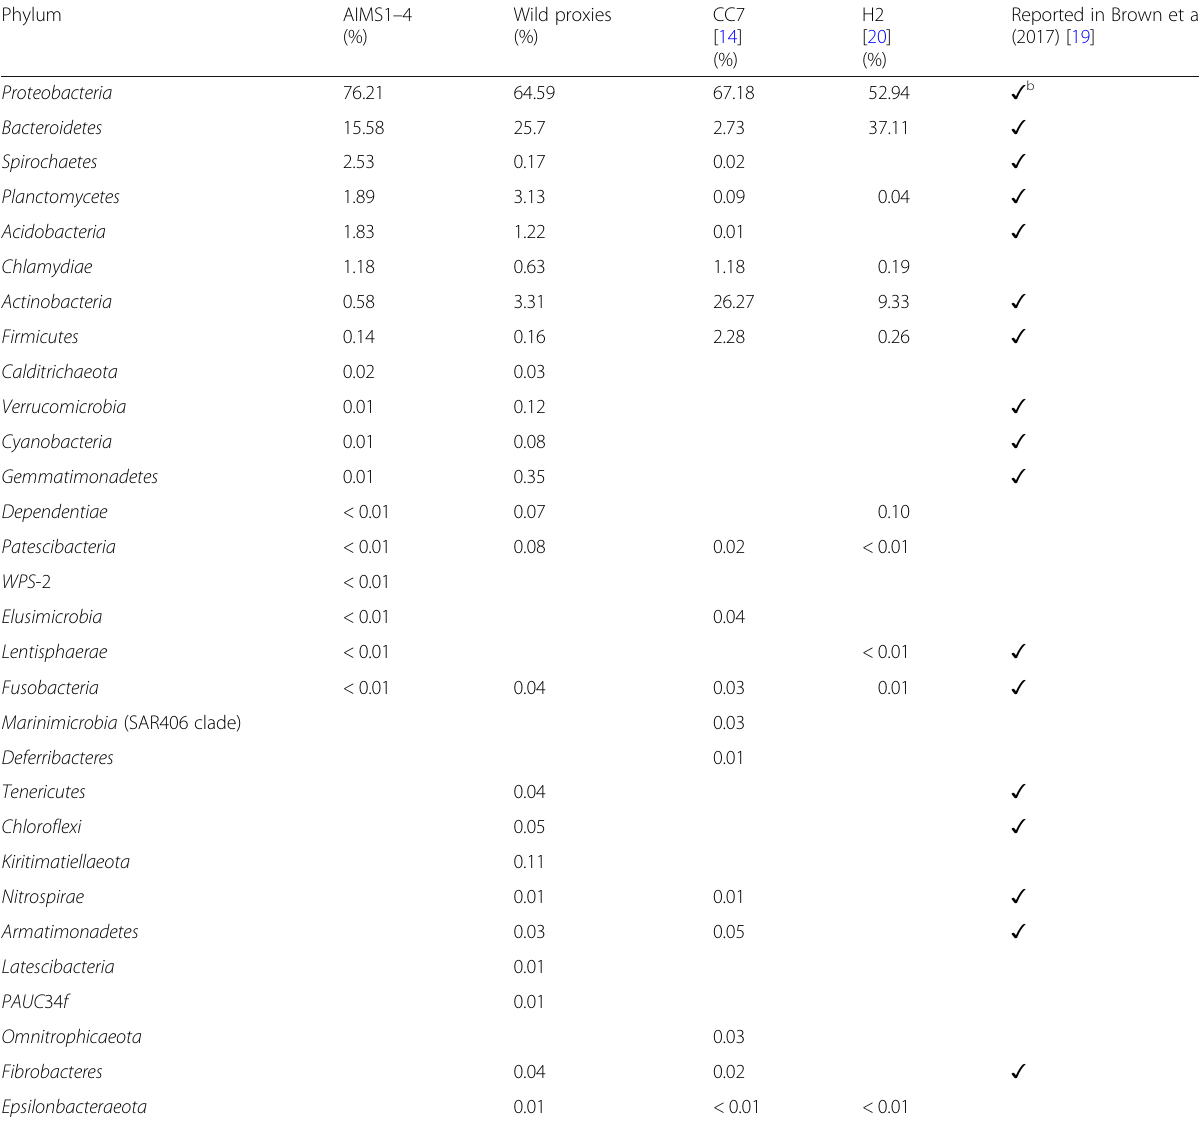
Table 4 Phyla identified in the collective AIMS1 – 4 animals, wild proxies, CC7 [14] a , H2 [20] a , and previously reported [19]. See Supplementary Table S3, Additional file 5 for individual AIMS1 – 4 values